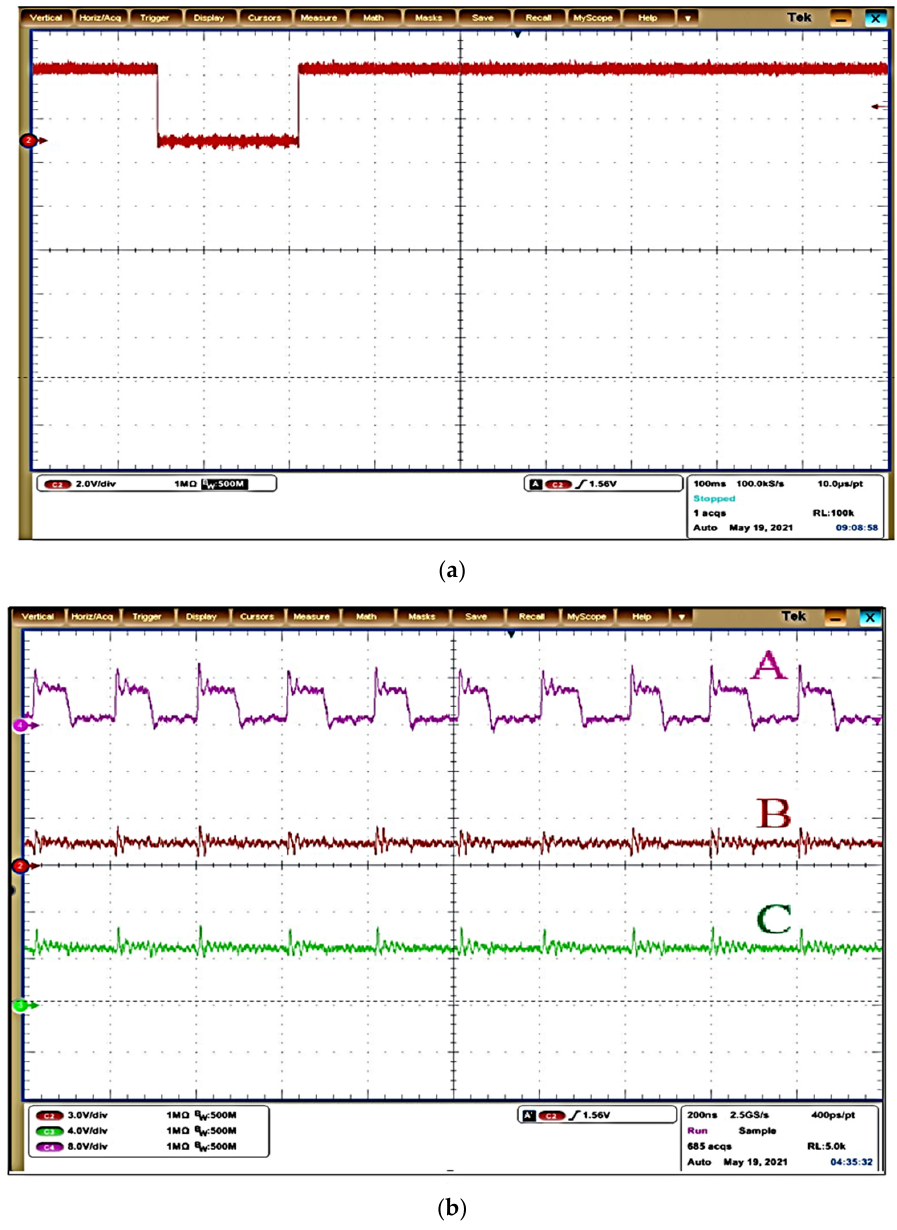
Figure 8. Experiments results: ( a ) input trigger signal; ( b ) inductor voltage V L after inductor (A), feedback voltage (B), and output voltage (C). (Scale 0.1 μ s/div and 2.0 V/div).